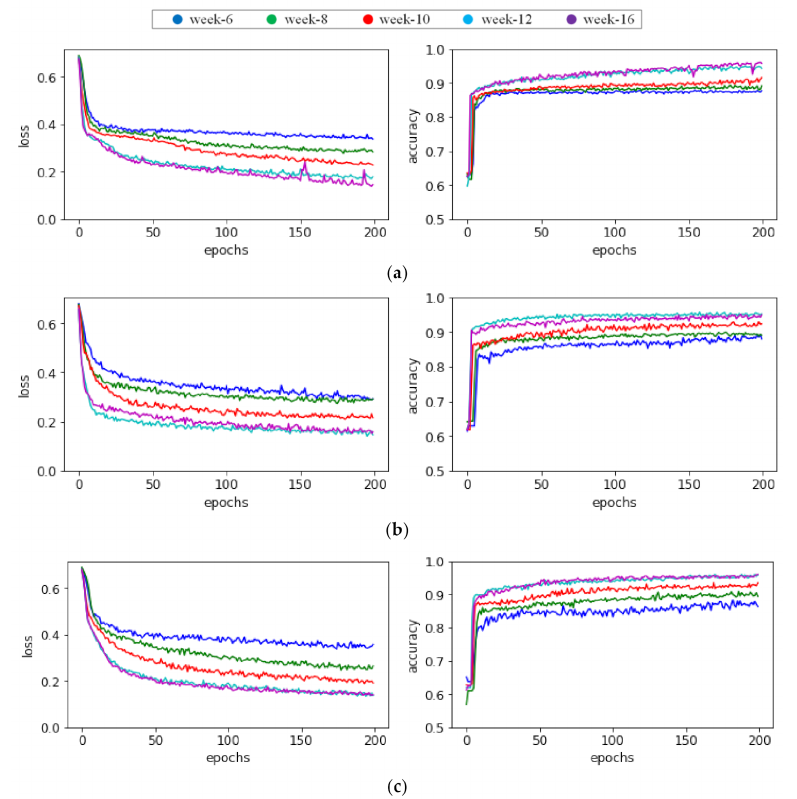
Figure 3. Week-wise validation loss and accuracy of three neural networks-based approach: ( a ) LSTM, ( b ) CNN-LSTM, and ( c ) Conv-LSTM.